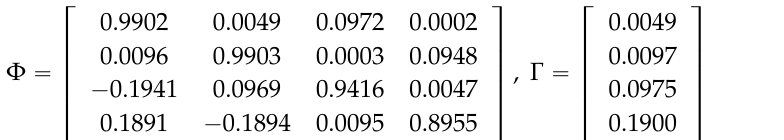
( d ) Figure 3. Optimal fusion estimator: ( a ) tracking for the position of M 1 ; ( b ) tracking for the position of M 2 ; ( c ) tracking for the velocity of M 1 ; and ( d ) tracking for the velocity of M 2 .